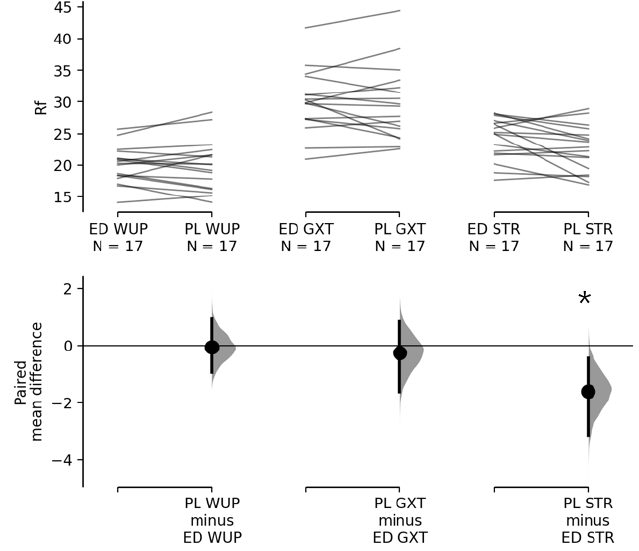
Figure 2. Paired mean difference for breathing rate ( R f ; breaths per min ) during the warm‐up (WUP), graded exercise test (GXT), and short‐term rest post exercise (STR) are shown above in the Cumming estimation plot. The raw data are plotted on the upper axes; each paired set of energy drink (ED) and placebo (PL) is connected by a line. On the lower axes, each paired mean difference is plotted as a bootstrap sampling distribution. Mean differences are depicted as dots; 95% confidence intervals are indicated by the ends of the vertical error bars [32]; * Significant differences between drinks ( p < 0.05).